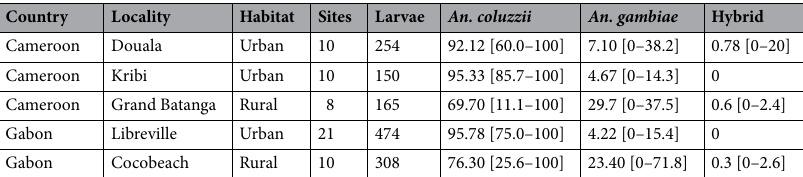
Table 1. Sampling locations and number of samples used in this study. Sites, number of breeding sites at each locality. Larvae, total number of samples analyzed (modelling and genomic analyses). An. coluzzii, mean frequency of this species per locality; in brackets the minimum and maximum